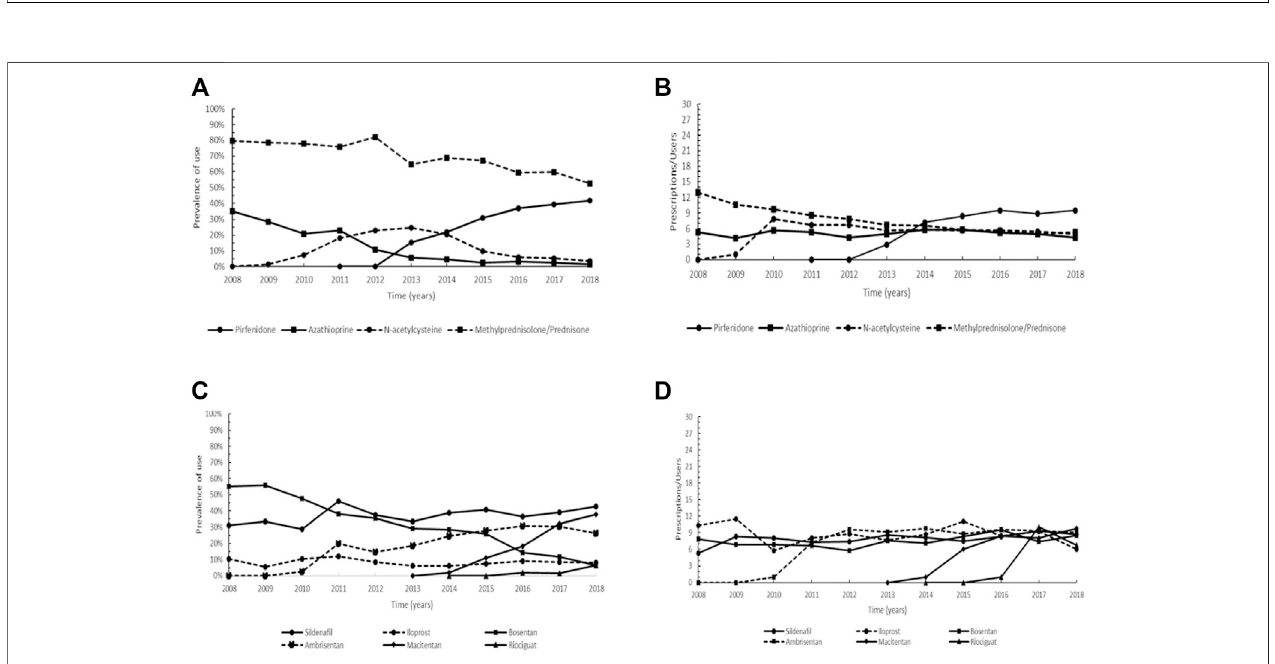
FIGURE 5 | Trend of the prevalence (graphs (A,C) ) and intensity of use (graphs (B,D) ) of the orphan drug pirfenidone and azathioprine, methylprednisolone/ prednisone, and N-acetylcysteine indicated for idiopathic pulmonary fi brosis and of bosentan, ambrisentan, macitentan, sildena fi l, riociguat, and iloprost indicated for pulmonaryarterial hypertension. Prevalenceofuse:ratiobetween thenumber ofcases withat leastoneprescriptionand thenumber ofprevalentcasesat thebeginning ofeachyear.Prescription/users:ratiobetweenthenumberofprescriptionsofeachmedicationforthetotalnumberofpatientswithatleastonedispensingperyear.